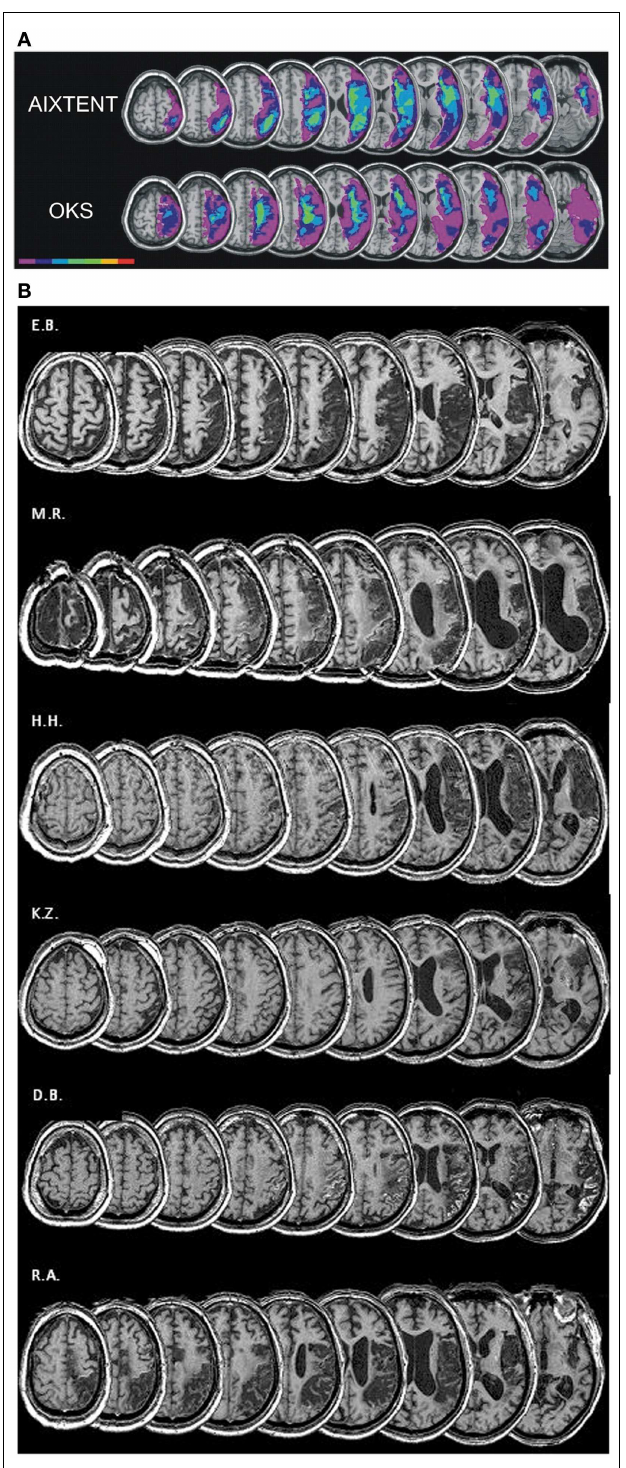
FIGURE 2 | (A) Overlay lesion plots for the AIXTENT (alertness-training) group ( n = 7) and OKS group ( n = 7;Thimm et al., 2009).The number of overlapping lesions is coded and indicated by the color bar from violet ( n = 1) to red ( n = 7). (B) Lesion plots of individual patients of the combined alertness + OKS training